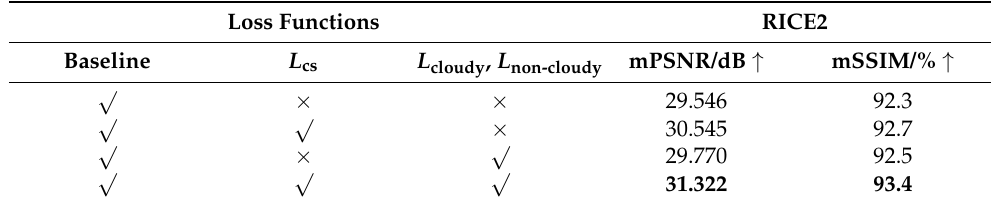
Table 5. Quantitative evaluation of DC-GAN-CL with different components of the loss functions using the RICE2 test